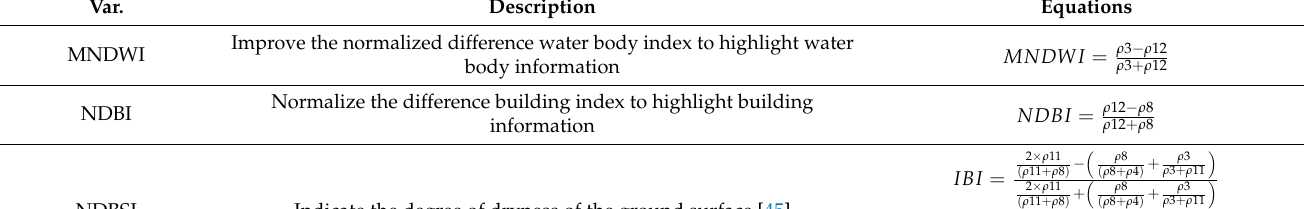
Table 1. Remote-sensing spectral indices required for downscaling and calculation formulas. Var. Description